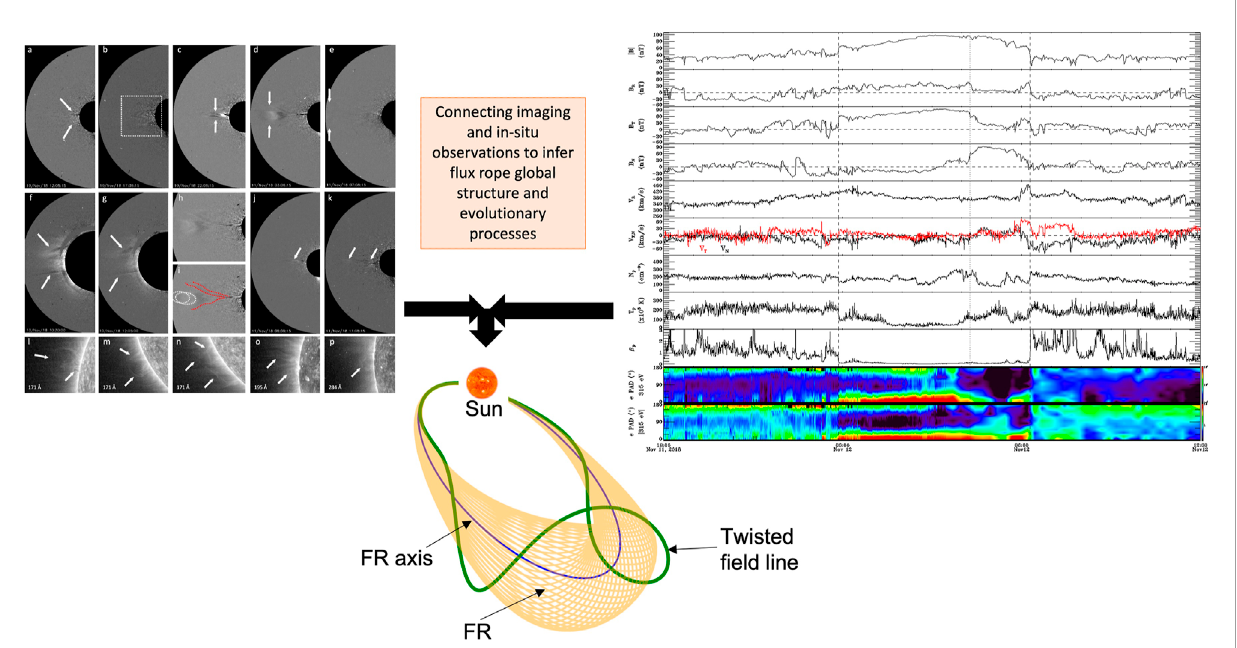
FIGURE 1 Example featuring the process of connecting the remote-sensing observations (from STEREO/EUVI and STEREO/COR2 and COR1) of a FR (left) and its local in-situ measurements (right) to infer the global internal structure and heliospheric evolution (middle). The two top images are reproduced from Nieves-Chinchilla et al. (2020) and the bottom cartoon is an adapted version of the Figure 4.5 in Carcaboso Morales (2021).